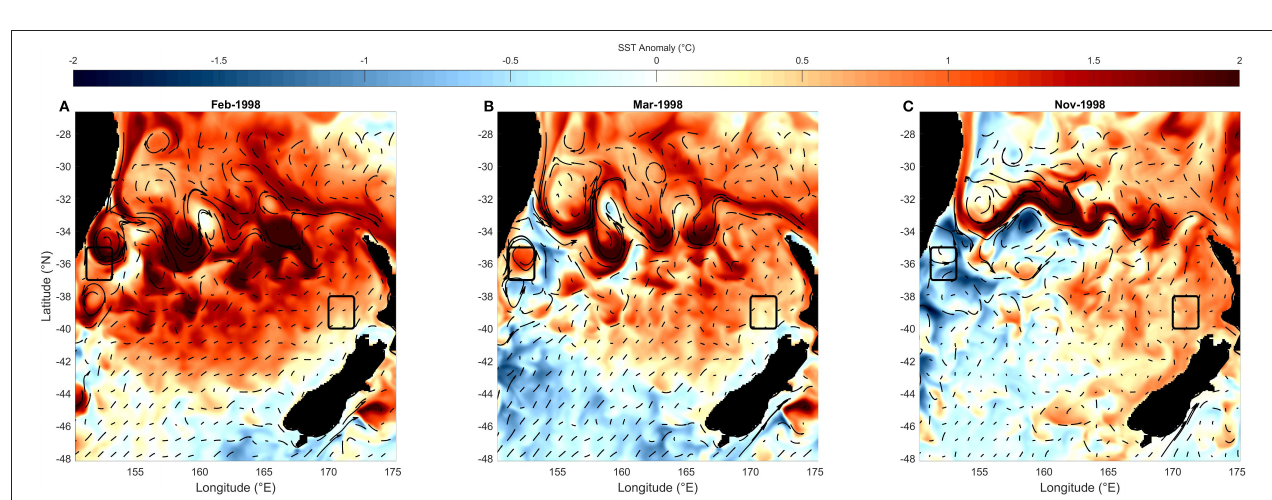
FIGURE 6 | Time-series of air-sea heatflux anomaly during 1998 in the NZ box (A) as calculated using the three MLDs: MLD 30 (green), MLD V (red), and MLD 150 (black). Dotted lines correspond to the Adv’ colorbar limits in panel (C) . (C) Hovmoller diagram showing anomalous advection with depth. MLD V is shown with a solid black line, MLD 30 and MLD 150 are marked by dashed lines. (E) Hovmoller diagram showing the temperature anomaly with depth. MLD V is shown with a solid black line, MLD 30 and MLD 150 are marked by dashed lines. (B,D,F) The evolution of salinity (B) , spice (D) and density (F) anomalies against pressure. Isopycnal surface contours of 25.9, 26.3, 26.6, and 26.9 kg m − 3 are shown using alternating dashed and solid lines (as per labels). MHWs are marked in the top panel with black rectangles. Drivers as identified by each scenario: MLD 30 , MLD V , and MLD 150 are labeled above each event in this order.